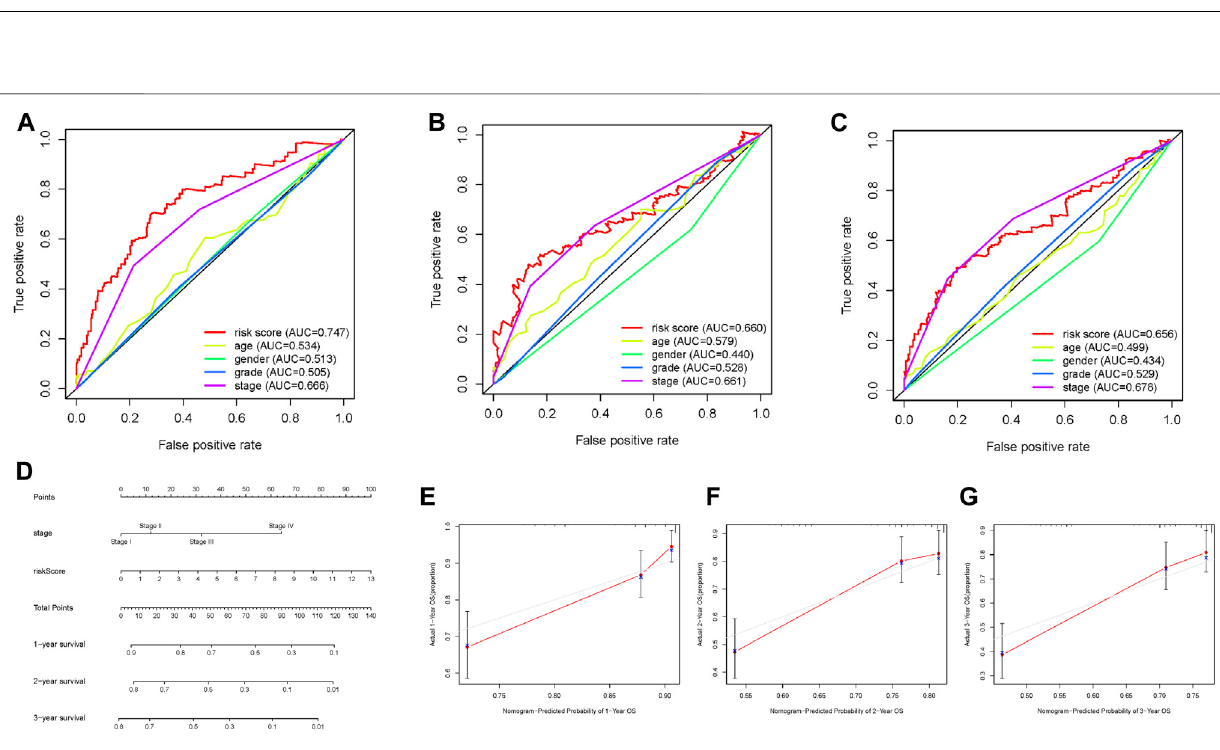
Frontiers in Molecular Biosciences |